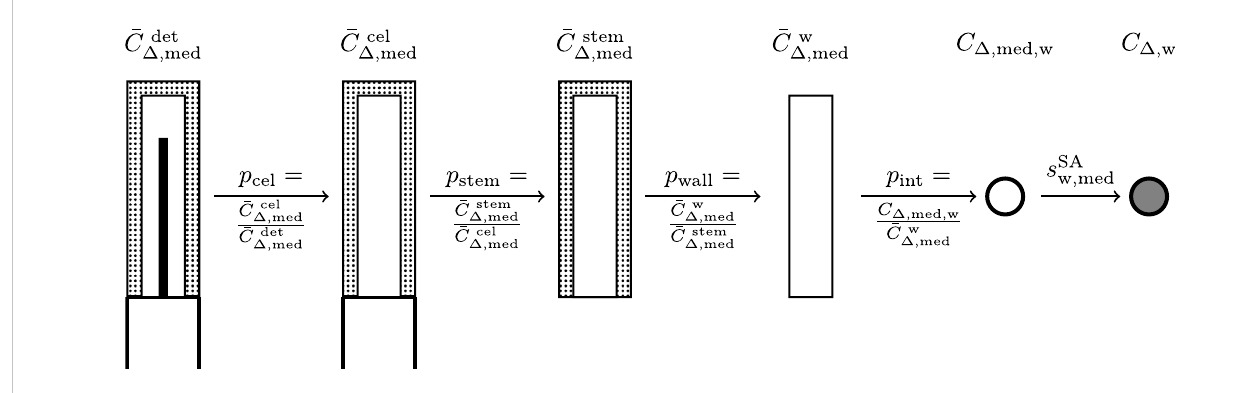
FIGURE 1 Schematic description of the determination of cema-based perturbation factors for air- fi lled ionization chambers. The principle of this determination methodwasoriginallyintroducedbyWulffetal.[18]andZinkandWulff[22].Inthisstudy,the fl uencecorrectionfactorsarecalculatedbycomparingthecema values in the cavity while speci fi c constructive details are missing. The internal fl uence correction factor p int includes the correction factors for the volume- averaging effect p vol , the density effect p ρ and the displacement effect p dis . The last step describes the conversion between the cema in the air voxel and the cema in a water voxel, which can be described by the Spencer-Attix restricted stopping-power ratio water to the detector medium s SA w , med .